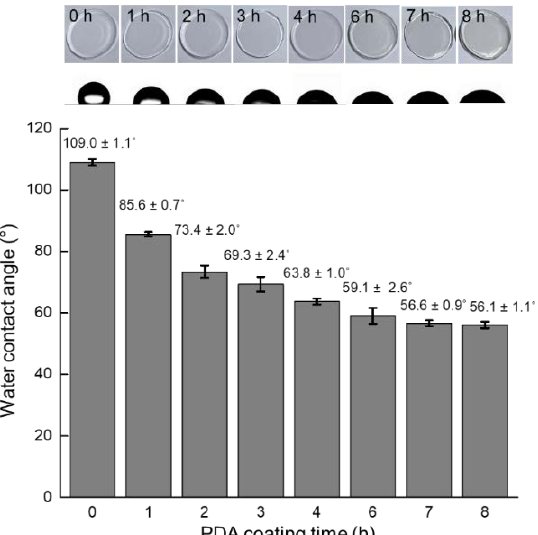
Figure 3. Water contact angles measured on the PDA-coated PDMS surface after coating for 0, 1, 2, 3, 4, 6, 7, and 8 h.